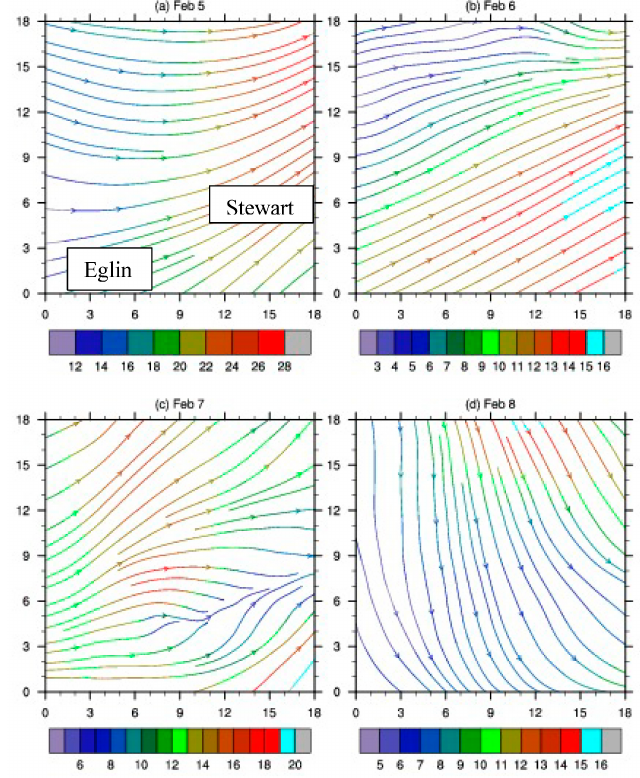
Figure 3. Streamlines and wind speed (m/s) at 850 hPa simulated with WRF. ( a – d ) are 5–8 February 2011 at noon local time. Wind speed is indicated by color.